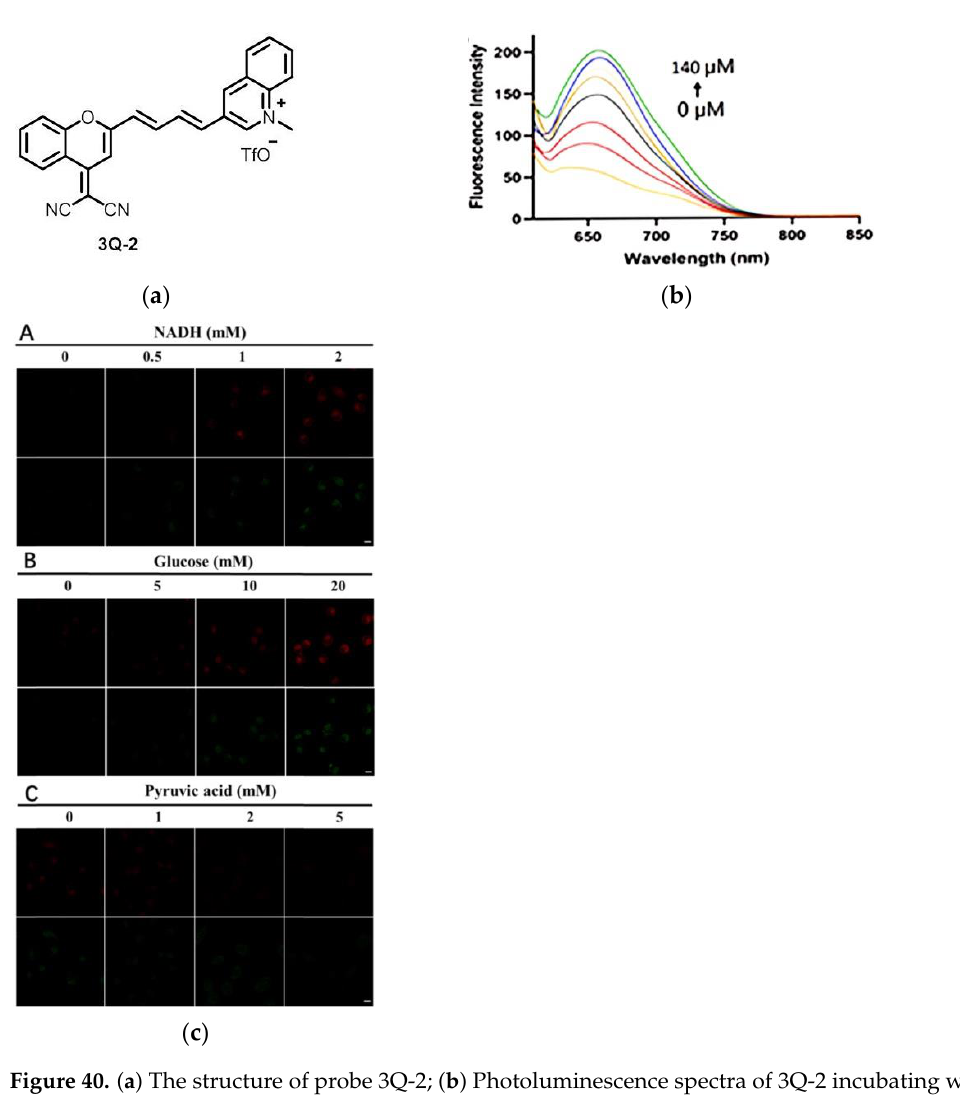
Figure 39. ( a ) Structure of probe Cy-N; ( b ) Fluorescence spectra of Cy-N; ( c ) Fluorescence imaging of NAD(P)H in HCT116 cells; ( d ) Fluorescence imaging of NAD(P)H in tumor-bearing mice. Re- produced with permission from [169]. Copyright 2021 Elsevier Ltd.